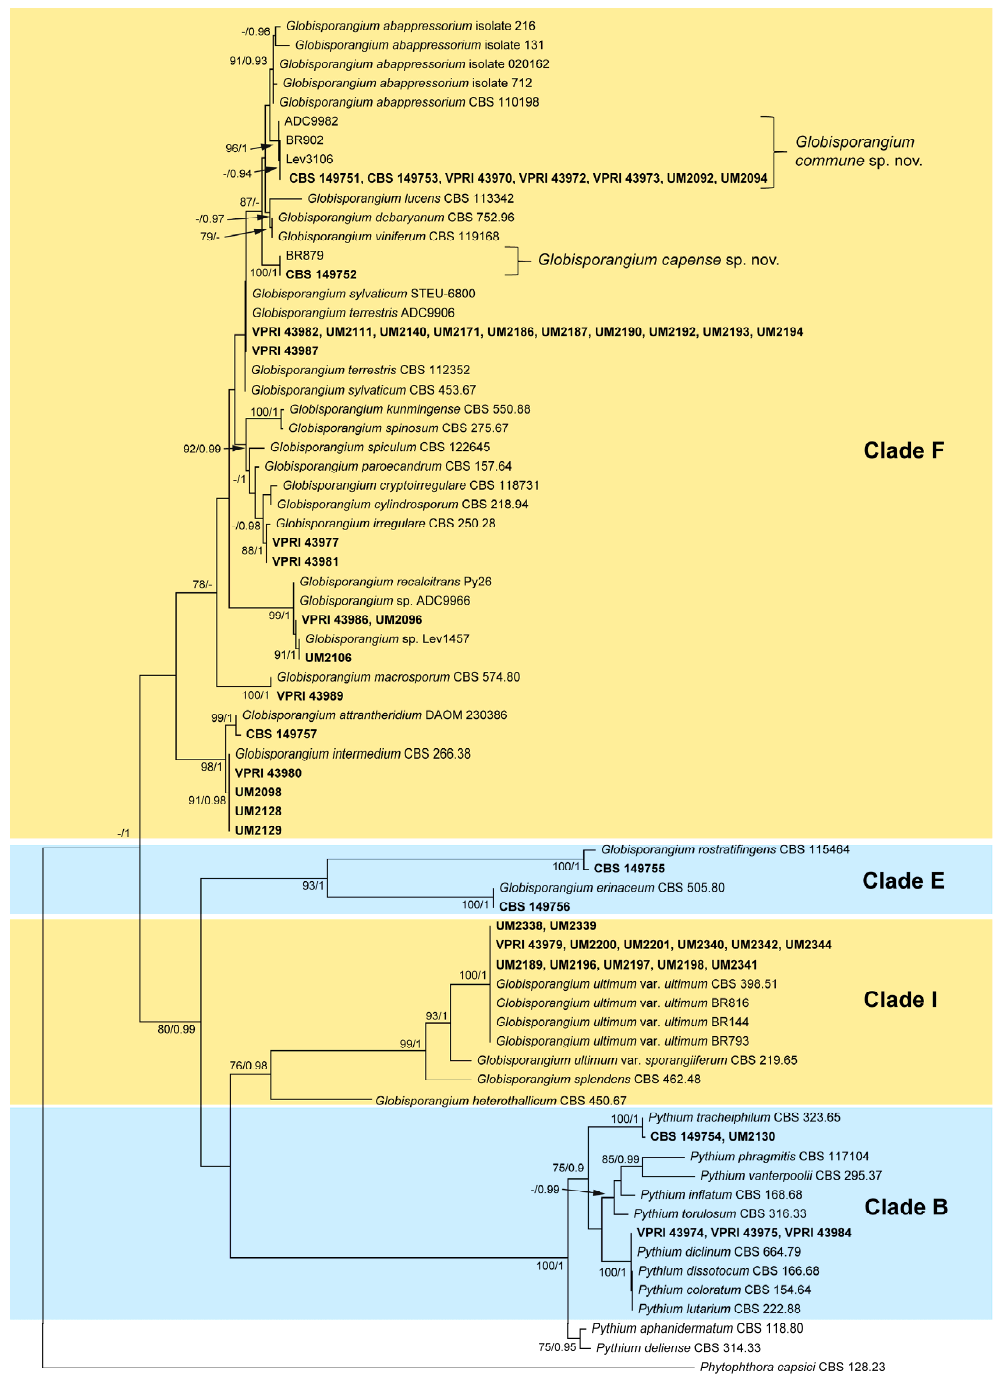
Figure 1. Maximum Likelihood (ML) phylogeny showing relationships among Pythium- like species based on ITS sequences. Isolates obtained and sequenced in this study are shown in bold. The ML bootstrap support values greater than 75% and Bayesian posterior probability values greater than 0.90 are indicated at internodes. The scale bar shows the number of nucleotide changes per site. The analysis involved 71 nucleotide sequences. The tree was rooted with Phytophthora capsici CBS 128.23 [26]. The clades highlighted were decided based on established phylogeny from Lévesque and De Cock [15].